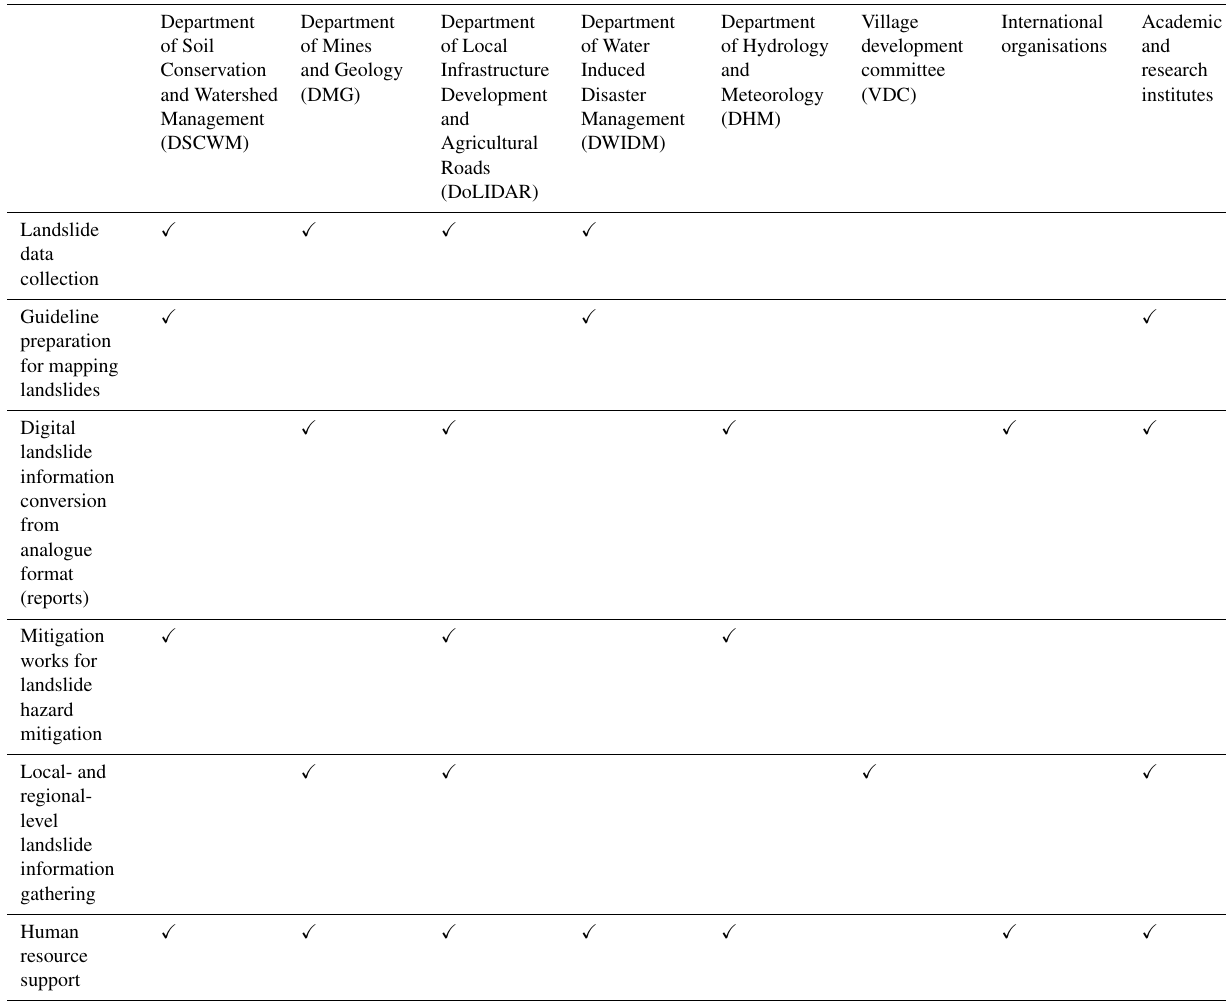
Table 3. Functionality and associated requirements requested by